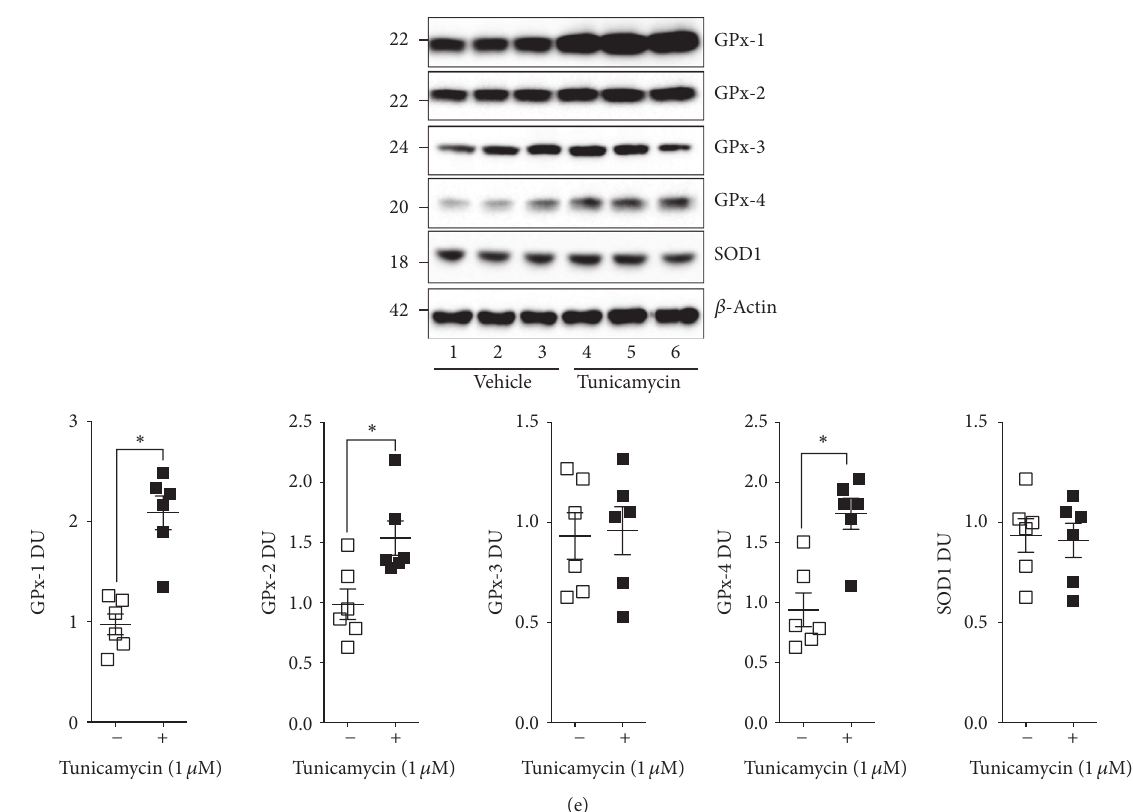
Figure 7: Effect of ER stress-induced tunicamycin on the antioxidant expression profile in mouse precision-cut lung slices (PCLS). PCLS were obtained from wild type mice and were exposed to tunicamycin (1 𝜇 M) for 24 hours. (a) LDH release into media and (b) Chop , Atf4 , Atf6, and Xbp1 gene expression were examined. (c) Immunoblots were conducted for Chop , Atf4 , Atf6, Xbp1, and 𝛽 -actin. (d) GPx-1, GPx - 2, GPx - 3, GPx - 4, and Sod1 were quantified by qPCR and (e) immunoblots analysis. Every lane represents an individual mouse. Dot plots are represented as relative quantification (RQ) compared to ACTB expression or densitometry units (DU) of pixel intensity expressed as a ratio to 𝛽 -actin. Data are shown as the mean ± SEM, where each measurement was performed on 3 independent days on 6 donors/group. ∗ denotes a 𝑝 value < 0.05, when comparing both treatments connected by a line, determined by Student’s 𝑡 -test (2 groups).